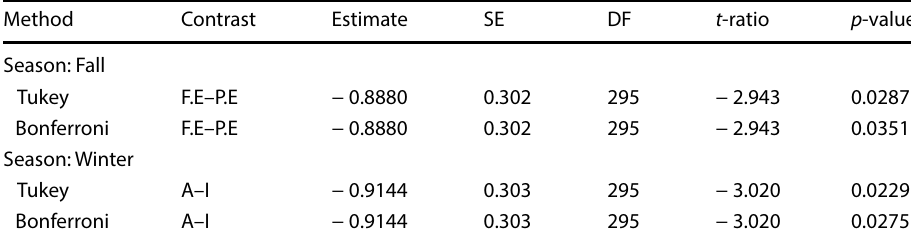
The p -value adjustment for Tukey’s HSD method (Bonferroni) compared a family of 5 (10)